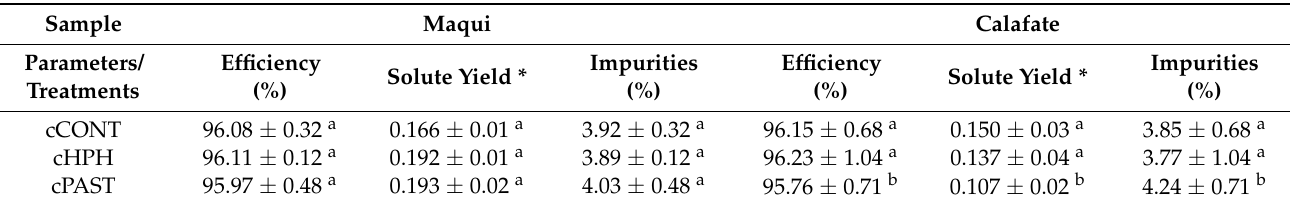
Table 3. Cryoconcentration parameters (separation efficiency, recovered solute yield, and impurities) in aqueous maqui and calafate